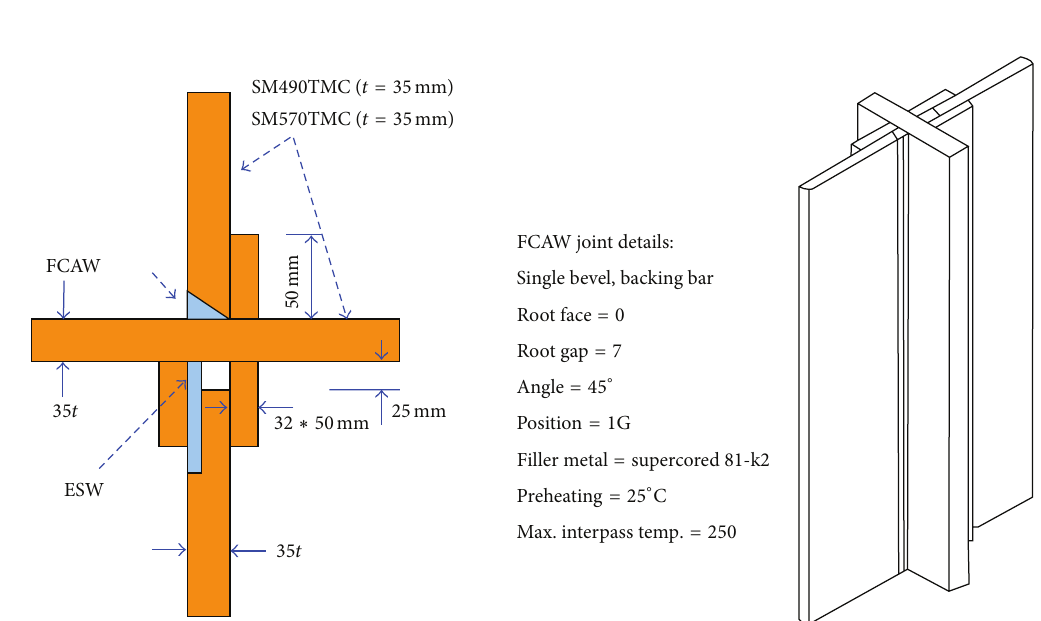
Figure 3: Welding test steel plate before being